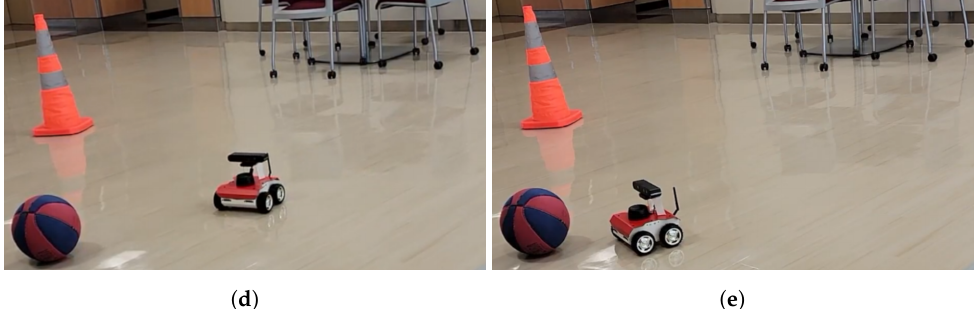
Figure 15. ( a ) No obstacle Unity frame. ( b ) The initial position was manually setup. ( c ) Second coordinate position. ( d ) Third coordinate position. ( e ) Final coordinate position, where the rover has reached the goal.